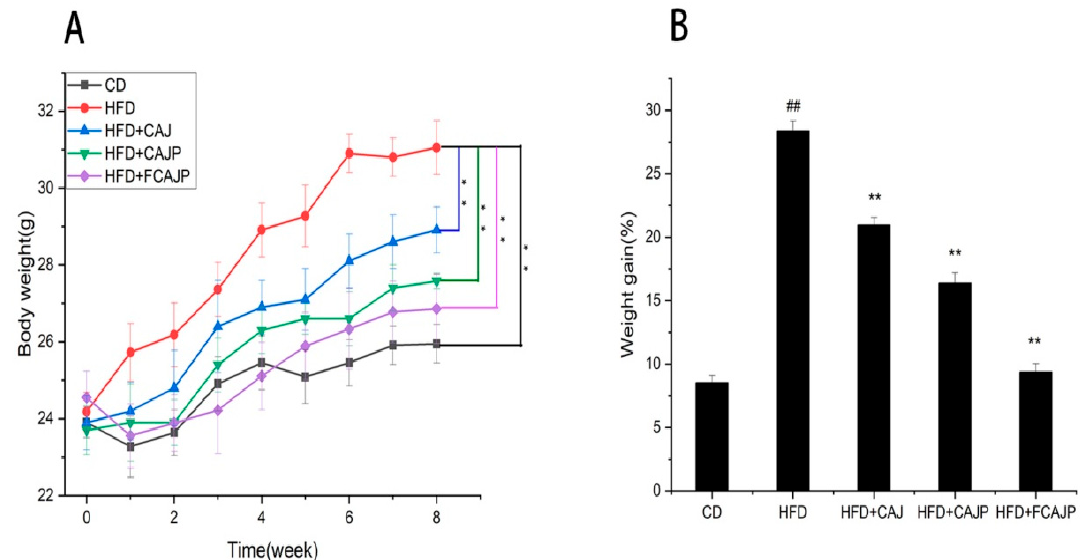
Figure 1. ( A ) Body weight of five groups in different periods of 8 weeks and ( B ) weight gain of five groups ( n = 8). Note: